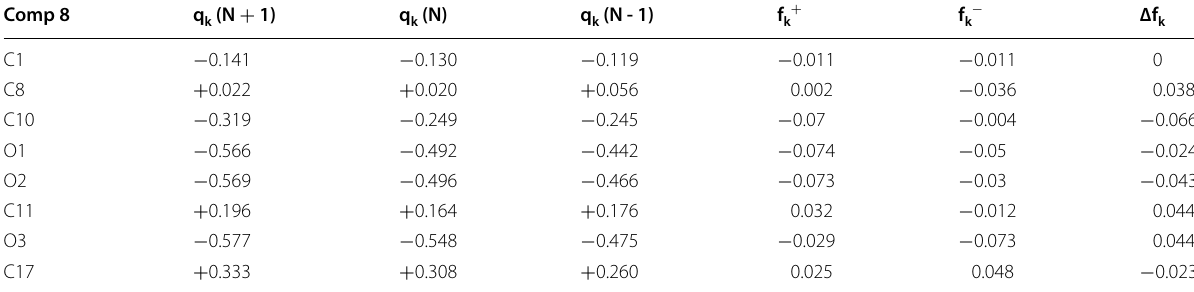
Table 9 Selected Mulliken atomic charges and Fukui functions for Compound